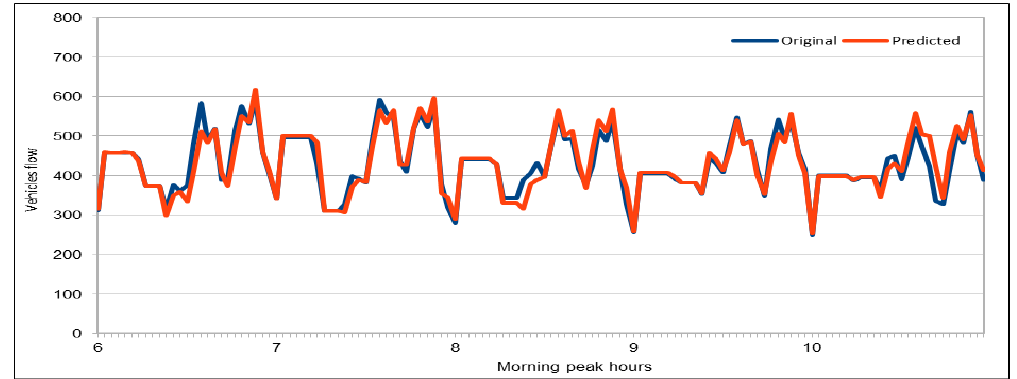
Figure 20. Comparison of original and predicted flow values on morning peak